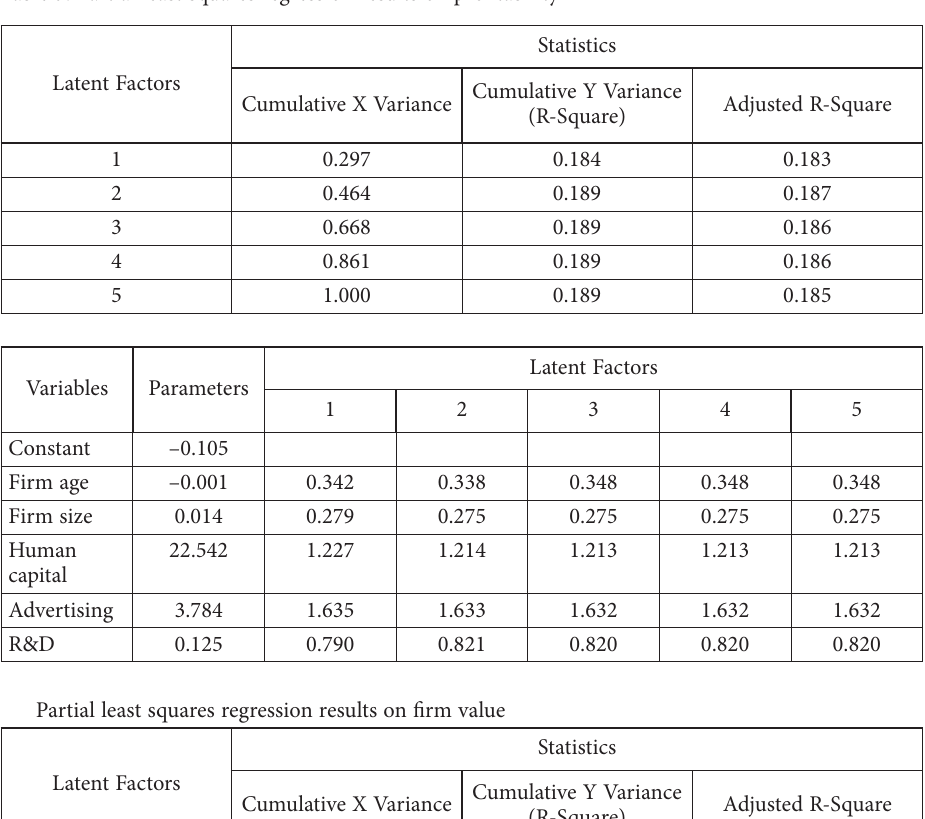
Table 5. Partial least squares regression results on